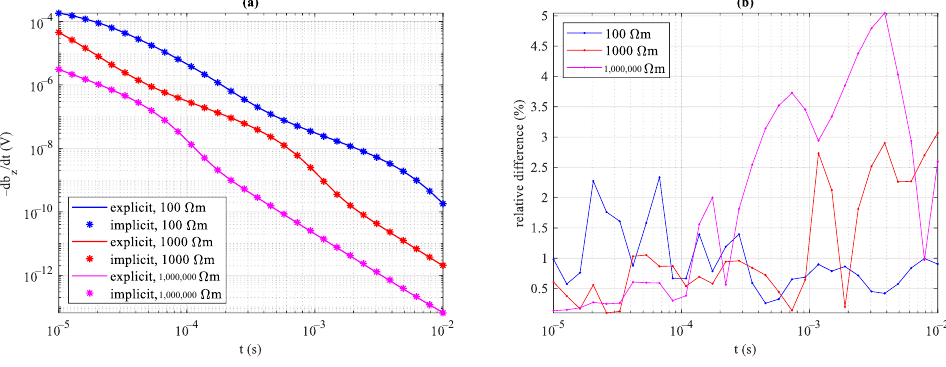
Figure 10. Example 3: ( a ) forward modeling responses; ( b ) relative differences between the solutions of explicit and implicit